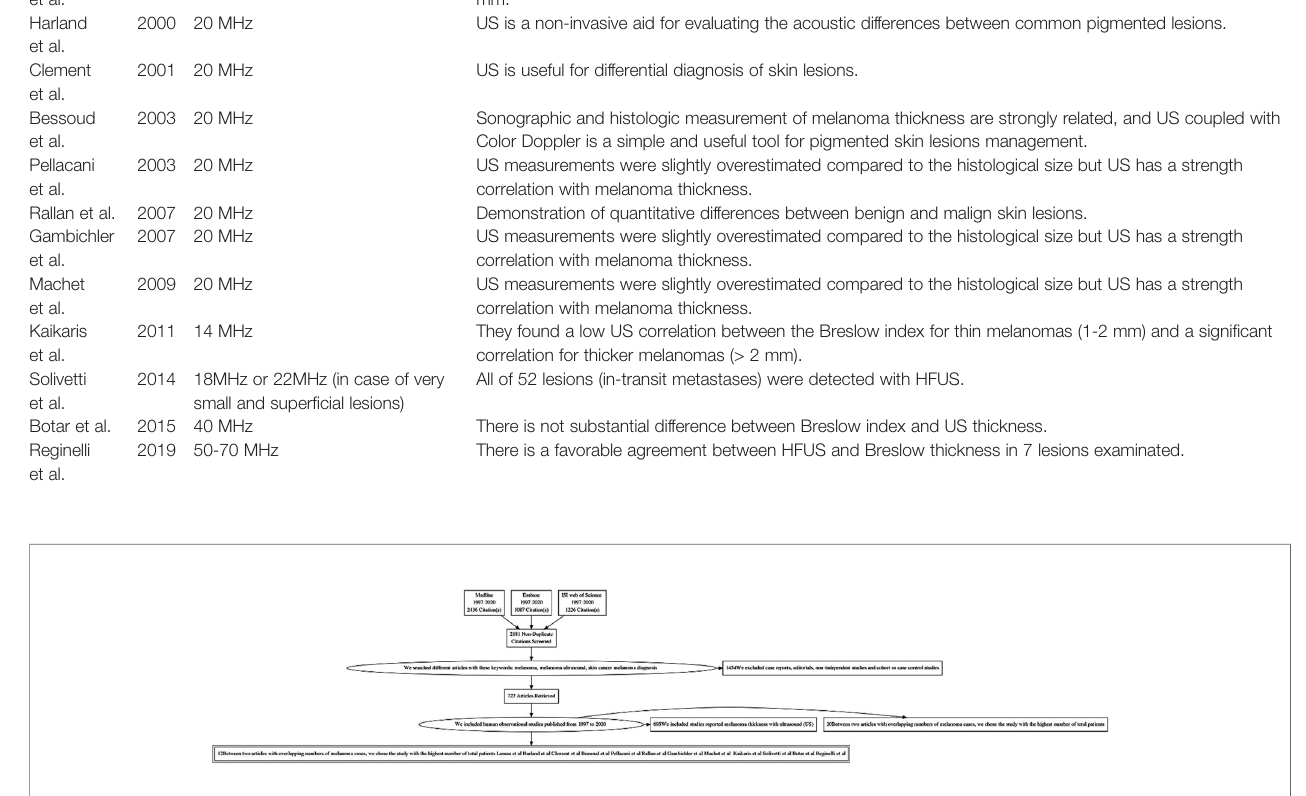
FIGURE 4 | PRISMA fl ow